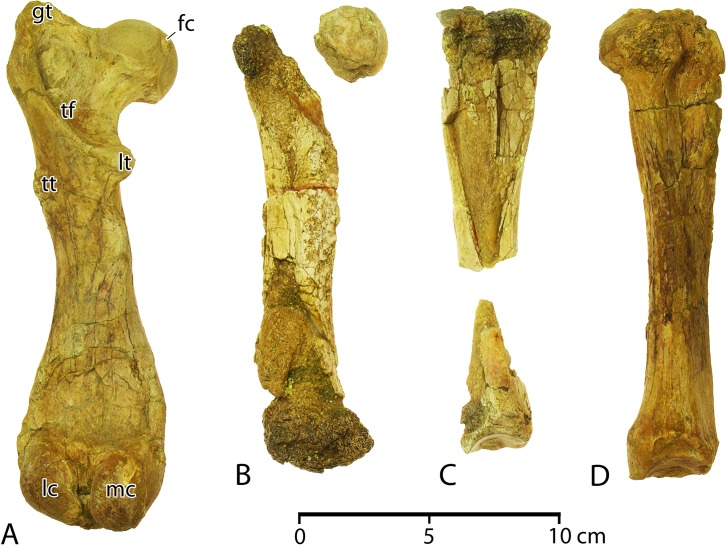
Sexual dimorphism in Aegicetus gehennae.A, left femur of CGM 60584 interpreted as male, in posterior view. B, weathered left femur of CGM 60583 interpreted as female, in posterior view. C, right tibia of CGM 60583 interpreted as female, in lateral view. D, right tibia of CGM 60584 interpreted as male, in lateral view. Elements interpreted as male average 11% larger in linear dimensions than elements interpreted as female. Abbreviations: fc, fovea capitis femoris; gt, greater trochanter; lc, lateral condyle; lt, lesser tuberosity; mc, medial condyle; tf, trochanteric fossa; tt, third trochanter.